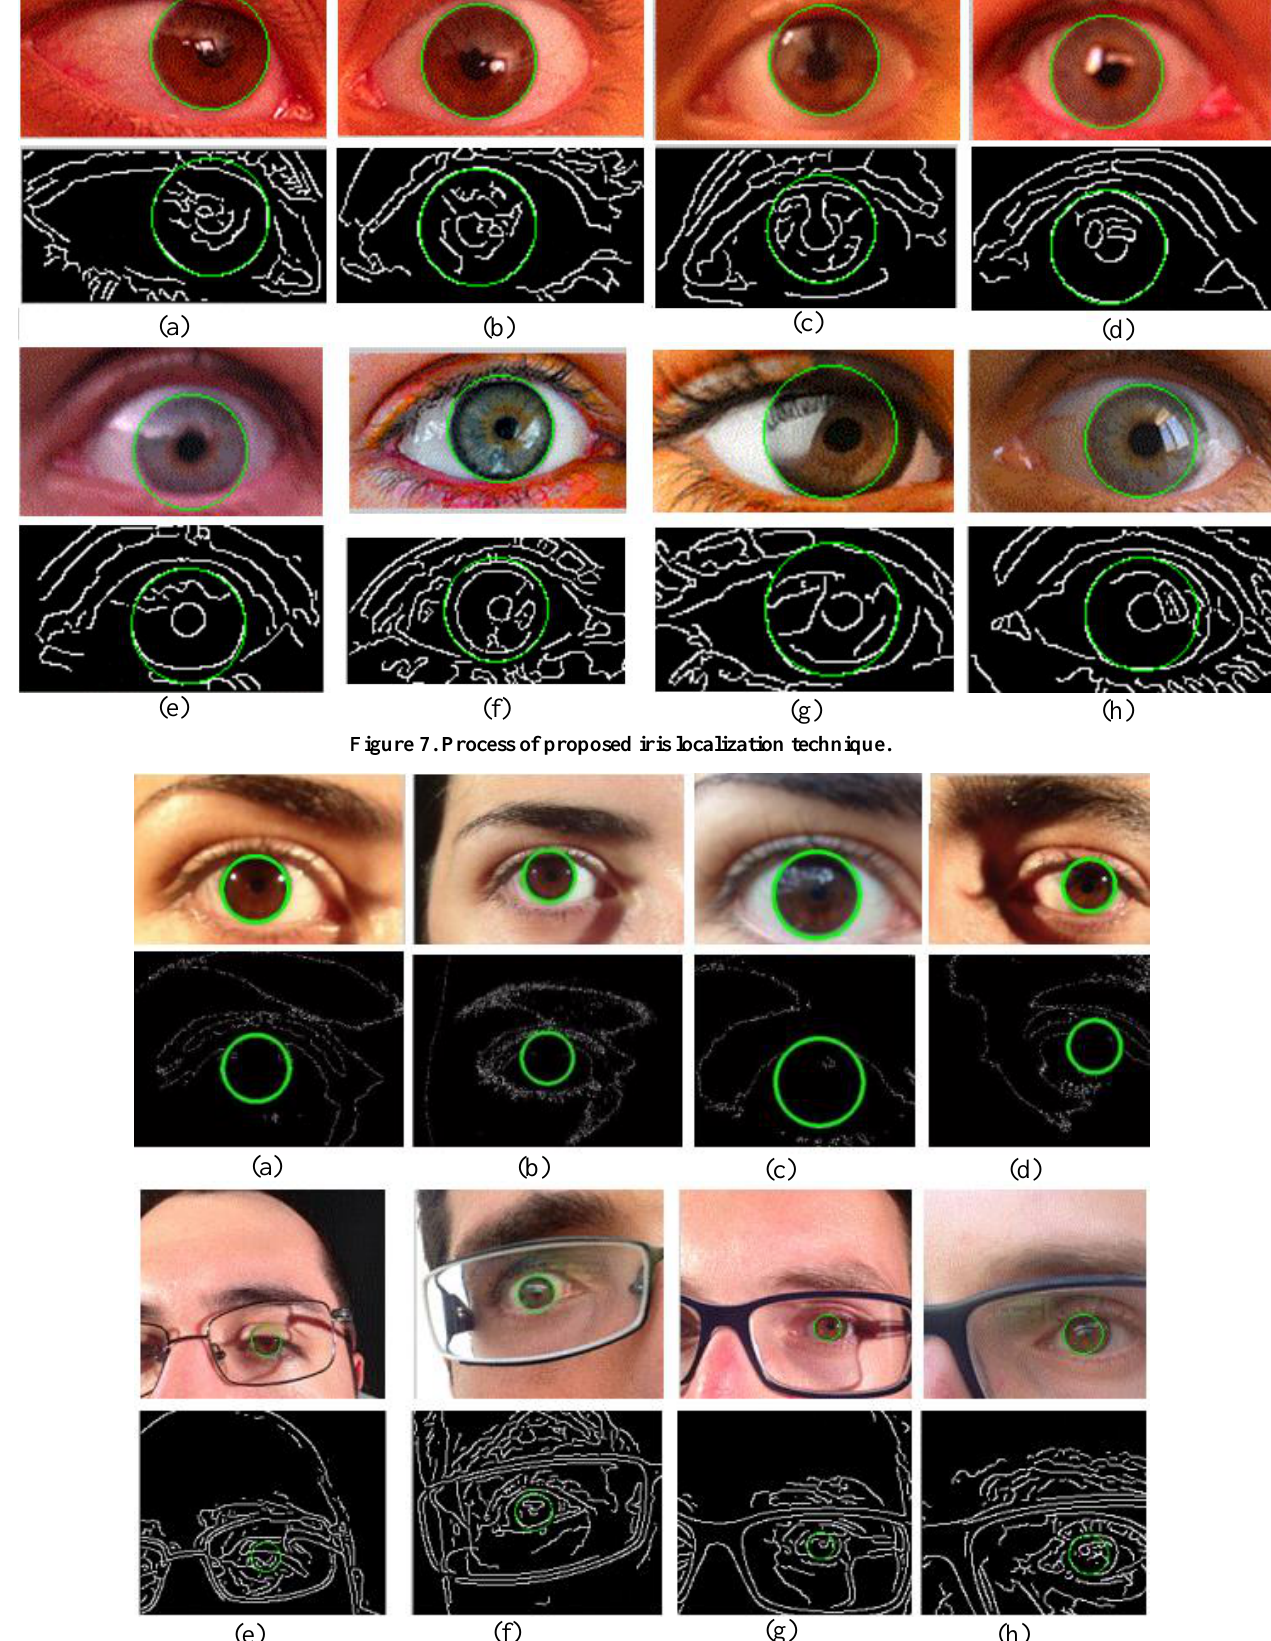
Figure 8. Results of iris detection on iphone5